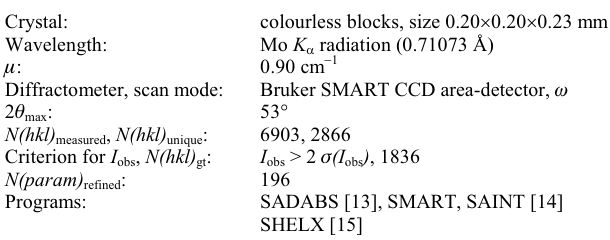
Table 1. Data collection and handling.